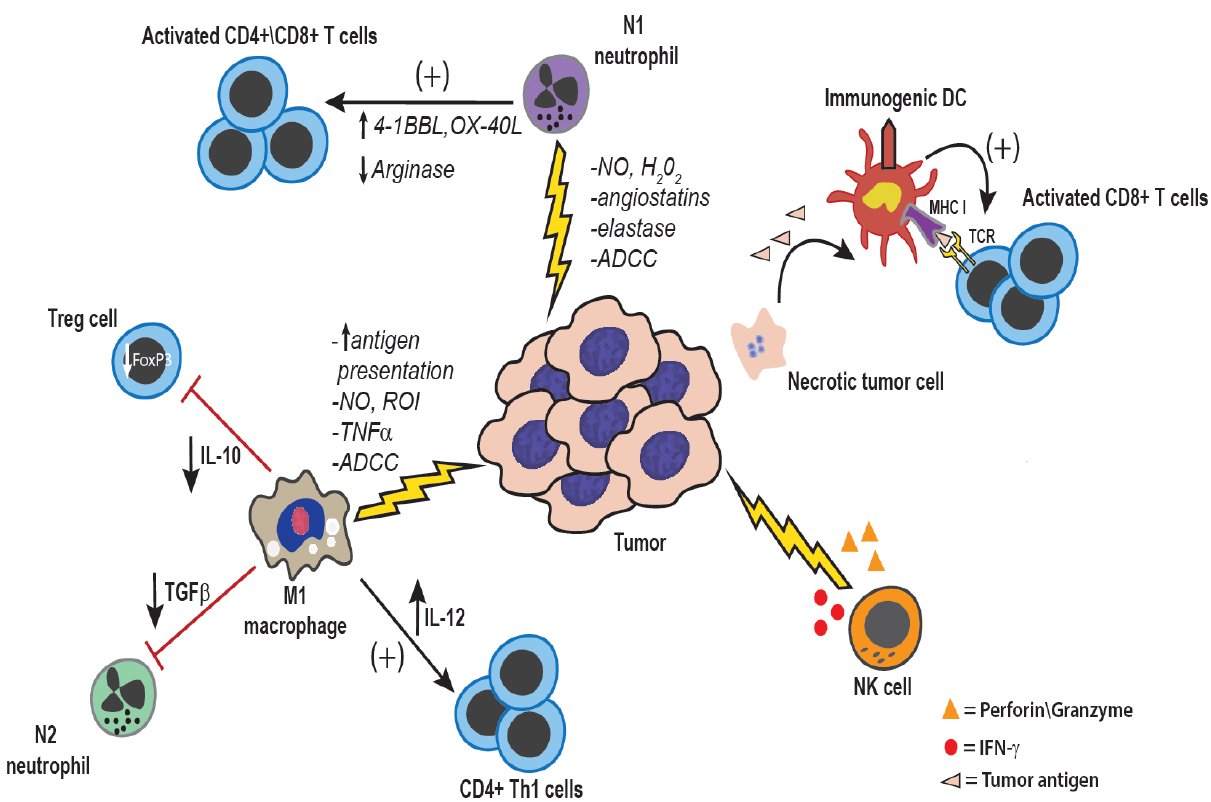
Figure 2. Anti-tumor effects of innate immune cells: Both tumor-associated macrophages and neutrophils can be polarized to a more pro-inflammatory anti-tumor phenotype, either inherently within certain tumor types, or through therapeutic manipulation. Direct anti-tumor mechanisms of macrophages and neutrophils are mediated by production of reactive nitrogen and oxygen intermediates, cytokines such as TNF-α, and enzymes such as elastase [25,31]. Additionally, through the production of IL-12, macrophages can activate NK cells as well as induce a Th1 type anti-tumor immune response [32]. NK cells are also potent anti-tumor innate immune effector cells. NK cells are activated in response to reduced expression of MHC I and by ligation of activating receptors such as NKG2D [33]. NK cells mediate direct tumor cell killing via perforin and granzyme, or expression of FasL and TNF-related apoptosis-inducing ligand (TRAIL) [33]. Additionally, NK cells are an important source of IFN-γ within the tumor microenvironment, which serves to activate macrophages, and DCs, and up-regulated MHC I and MHC II expression on tumor cells and antigen-presenting cells, respectively